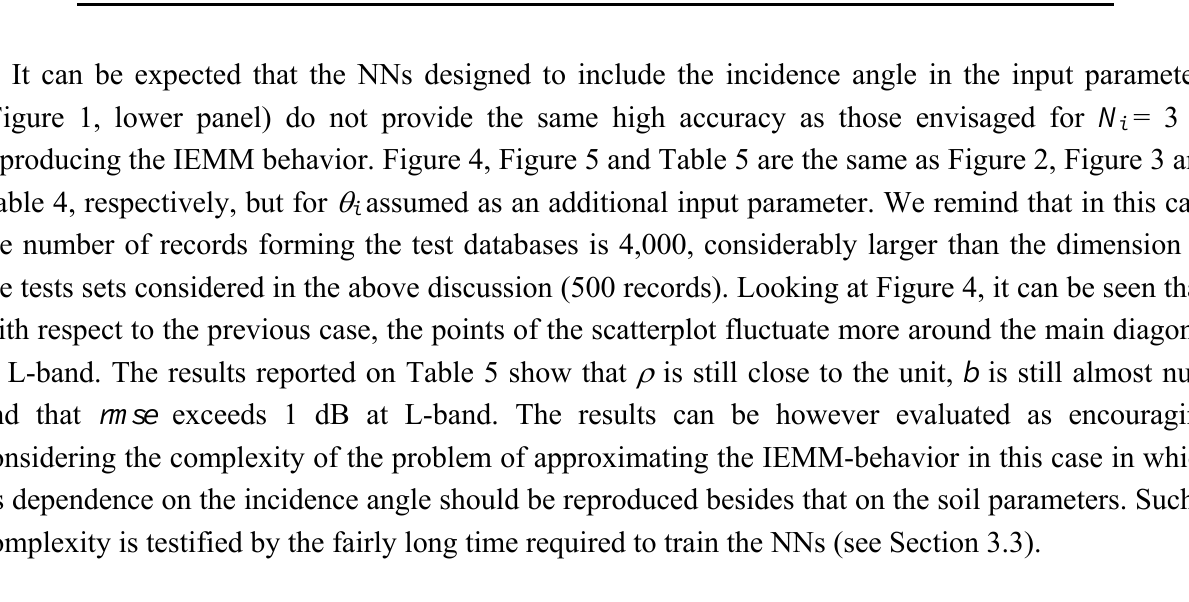
assumed as an additional input parameter (test sets i